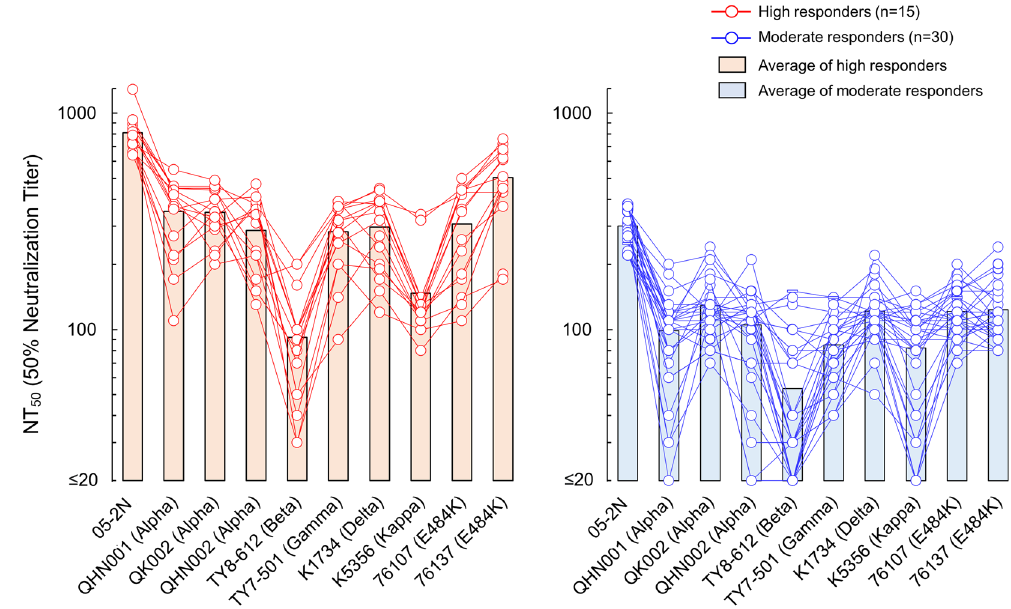
Figure 2. Neutralization of VOCs and VUM by day-60 sera from high and moderate responders. The activity of vaccinees’ sera to block the infectivity and replication of 9 SARS-CoV-2 variants (Alpha variants: SARS- CoV-2 QHN001 , SARS-CoV-2 QK002 , and SARS-CoV-2 QHN002 ; a Beta variant: SARS-CoV-2 TY8-612 ; a Gamma variant: SARS-CoV-2 TY7-501 ; a Delta variant: SARS-CoV-2 K1734 ; a Kappa variant: SARS-CoV-2 K5356 ; and E484K variants: SARS-CoV-2 76107 and SARS-CoV-2 76137 ) were evaluated. A Wuhan strain SARS-CoV-2 05-2N was employed as a reference SARS-CoV-2. Left panel shows results of high responders (n = 15), whereas right panel shows the results of moderate responders (n = 30). The NT 50 titers of each serum against SARS-CoV-2 variant are shown in red (high responders) or blue (moderate responders) circles, and bar represent average NT 50 titer of each group. P values for the difference between SARS-CoV-2 05-2N and each variant of high responders or